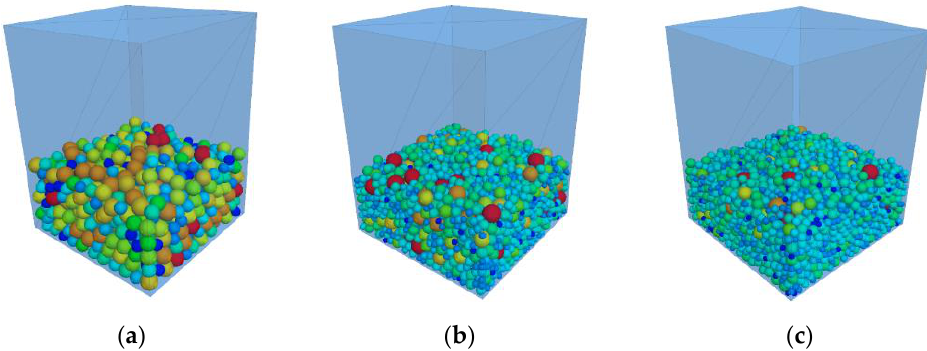
Figure 6. Schematic diagram of 19 – 31.5 mm aggregate and 9.5 – 19 mm aggregate in different mass proportions. ( a ) M 1 :M 2 = 100:0, ( b ) M 1 :M 2 = 30:70, ( c ) M 1 :M 2 = 0:100.